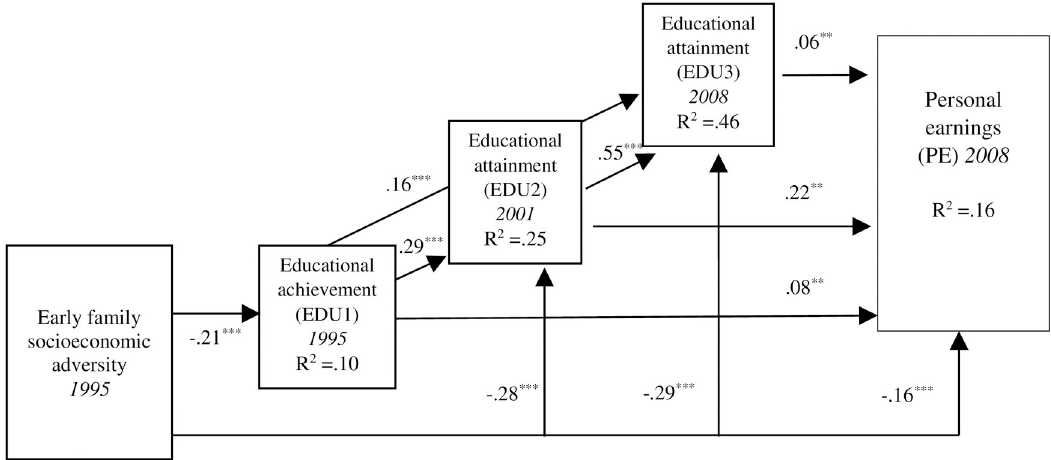
Fig 2. Model 1: Additive, cascading, and cumulative processes stemming from family socioeconomic adversity. Notes. Age was significantly associated with Ed1, Ed2, Ed3, and PE (-.23, .30, .16, and .06, respectively, p < .05). Gender (female) was significantly associated with EDU1, EDU2, EDU3, and PE (.06, .10, .06, and-.25, respectively, p < .05). Standardized coefficients are shown. �� p < .01. ��� p < .001. χ 2 (2) = 3.05, CFI = .99, RMSEA = .03, p < .001. CFI = 1.00. RMSEA =